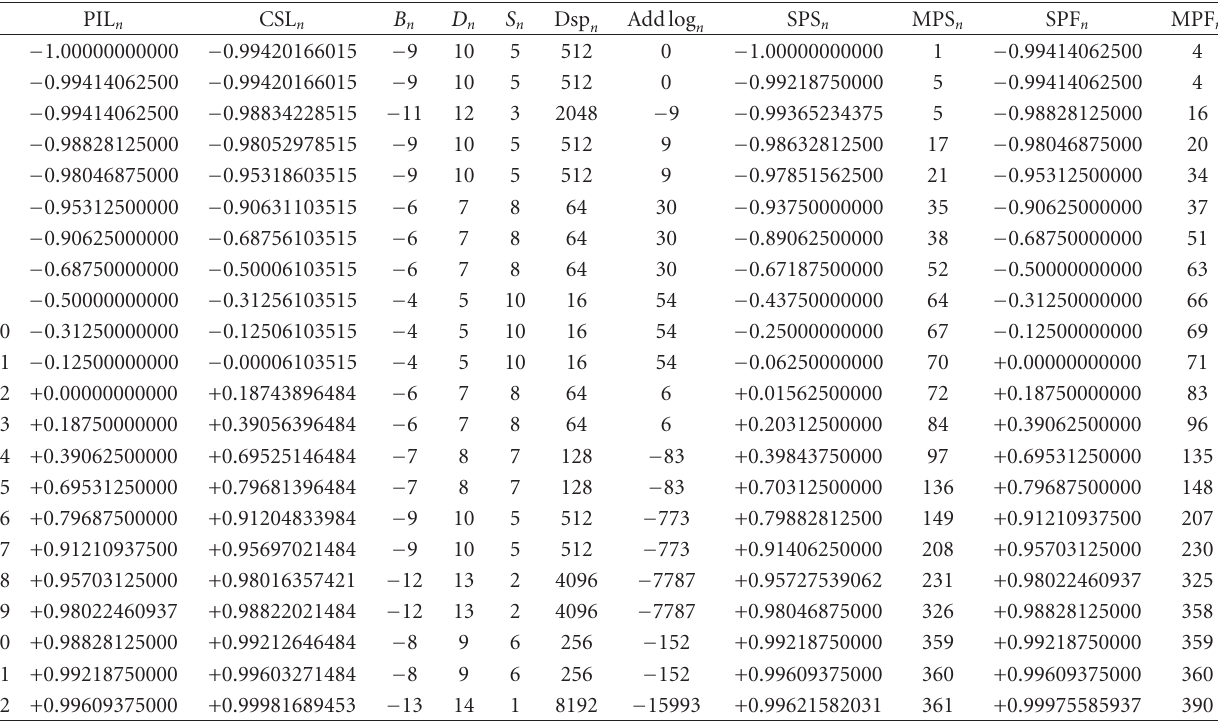
Table 6: Configuration parameters calculated for sampling scheme γ